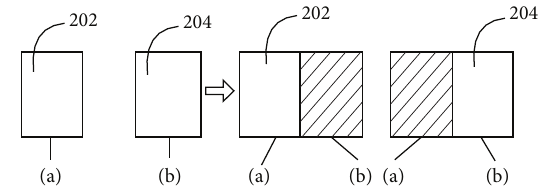
Figure 3: Division schematic diagram of adjacent zero communi- cation parallel cloud computing method.